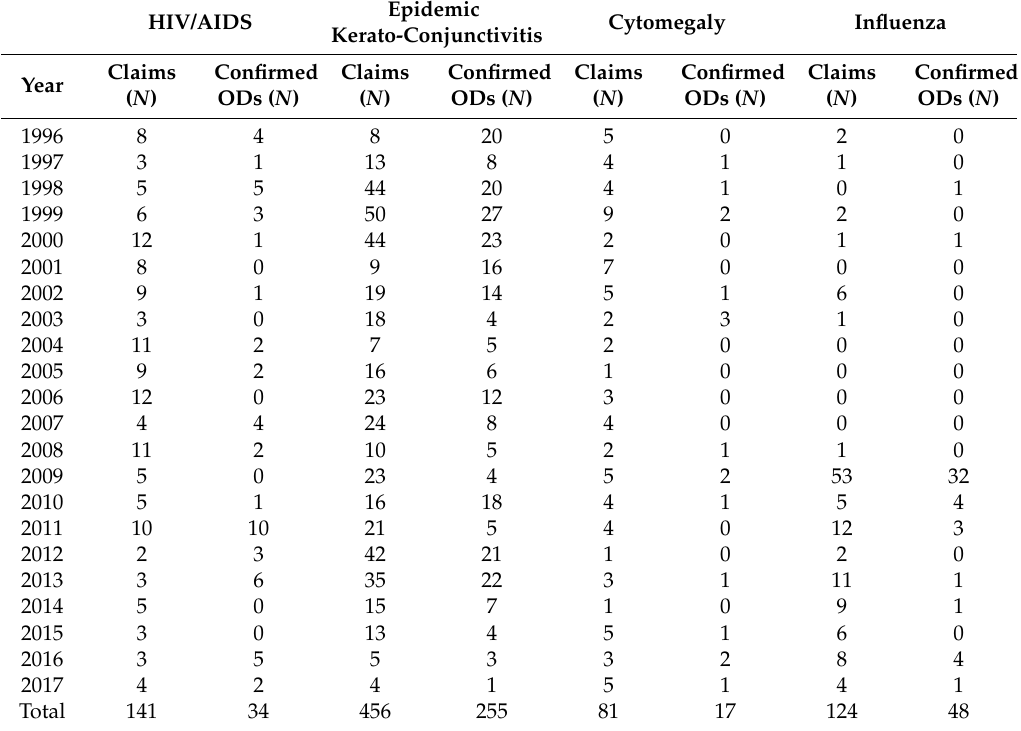
Figure 2. Hepatitis C: Claims and confirmed ODs from 1996 to 2017. Average confirmation rate for hepatitis C virus (HCV): 39.7% (total number of claims: 4761; total number of confirmed ODs: 1361).